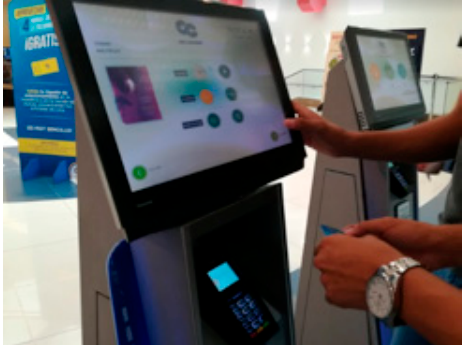
Figure 31. Interface of Cinema Colombia ticketing kiosk in Bogotá. A separate credit card terminal for taking card payments.